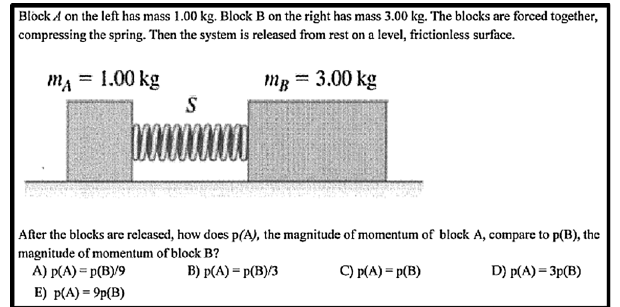
FIG. 6. An exam question about momentum from one of the institutions. It was categorized as conceptual.